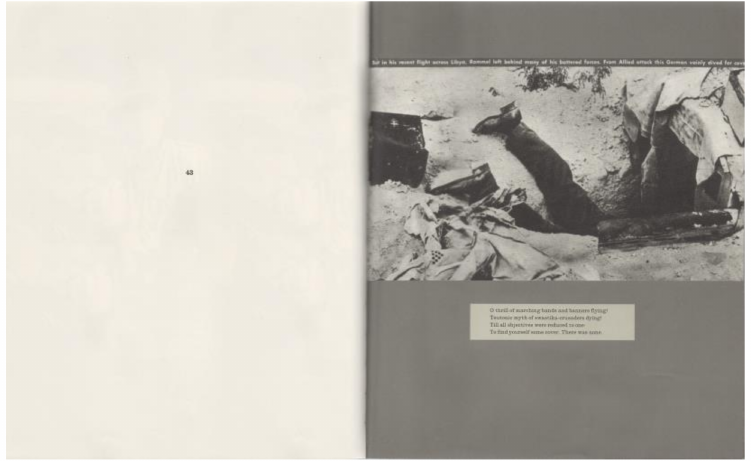
Figure 1. Plate 43. From Brecht. War Primer . 1998. Rommel’s flight across Libya.